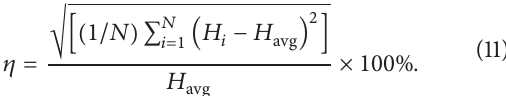
Figure 8: Average magnetic field strength variation when different GMM numbers and different loop numbers are